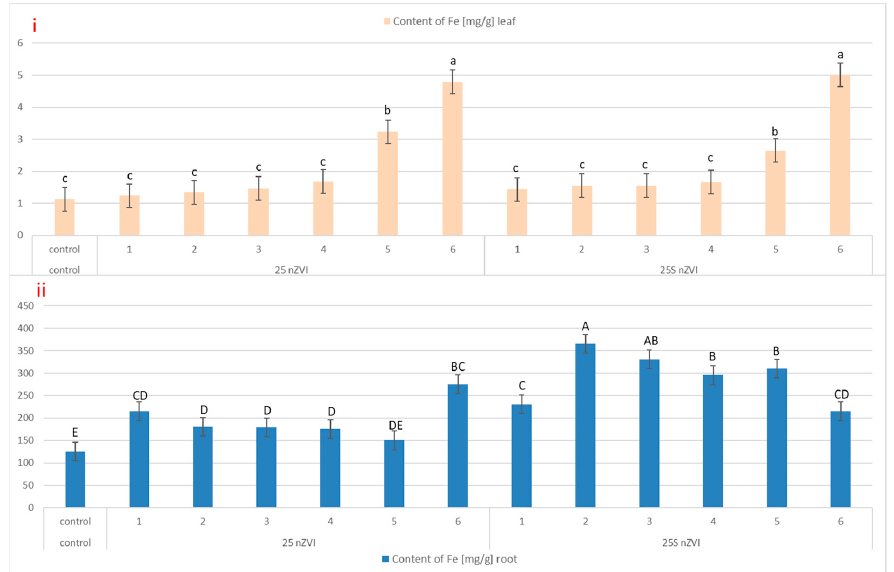
Figure 1. The concentration of iron (mg/g of soil) in the shoots ( i ) and roots ( ii ) of plants grown on soil contaminated with 25 and 25S nZVI. The numbers 1–6 correspond to the following concentrations: 0.5; 1; 5; 10; 50 and 100 g nZVI/kg soil. Vertical bars represents the mean values (n = 5) ± standard Agronomy 2021 , 11 , 467 deviations. Different letters indicate significant difference at p < 0.05 by LSD test.